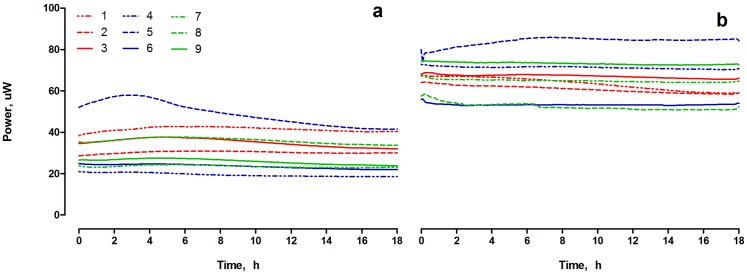
Temporal power performance of the individual MFCs in the cascade system observed during the first (a) and the second (b) trial.